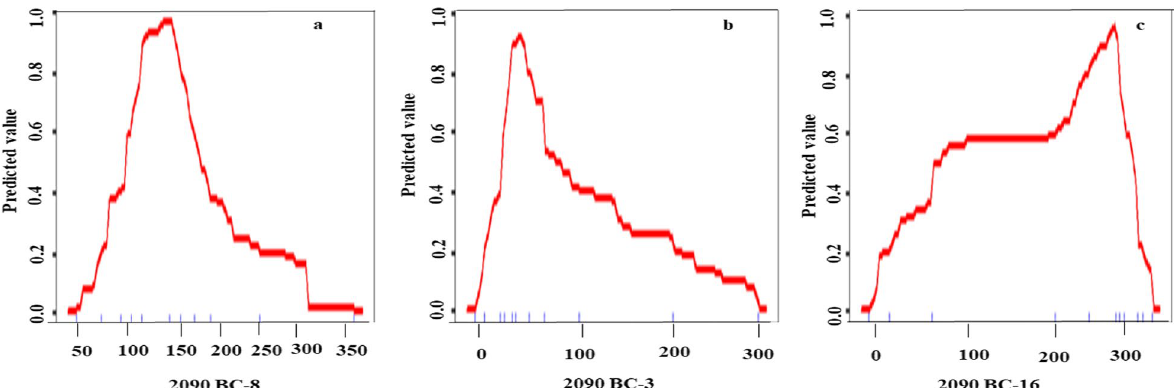
Fig. 7 Receiver operating characteristics curve (ROC) illustrating relationship between probability of occurrence of suitable conditions for distribution of C. wightii with most significant bioclimatic predictor during 2090 time frame: a MeTWeQ, b Iso and c PrWeQ